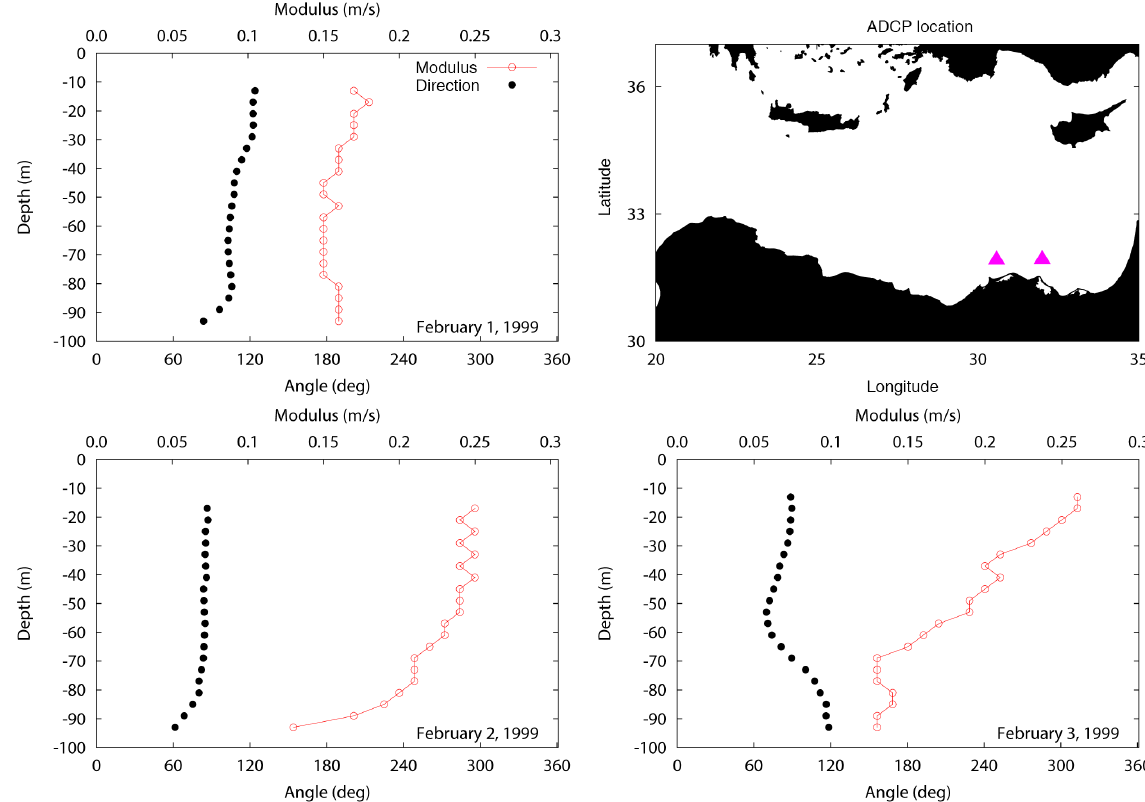
Figure 1. (Colour online.) Three instances of the observed instantaneous current profiles of the horizontal velocities, from the ADCP located at 31.91 ◦ N, 30.58 ◦ E; empty red circles: velocity modulus; black filled circles: direction from the north. In the top right panel, the small purple triangles indicate the ADCP